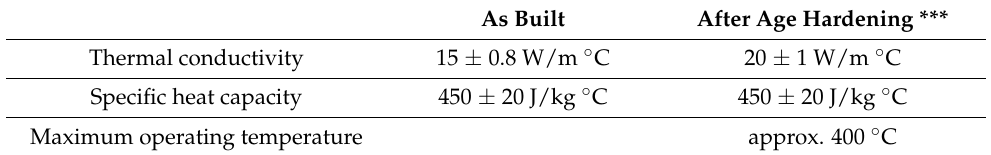
Table 3. Thermal properties of parts—Ti6Al4V